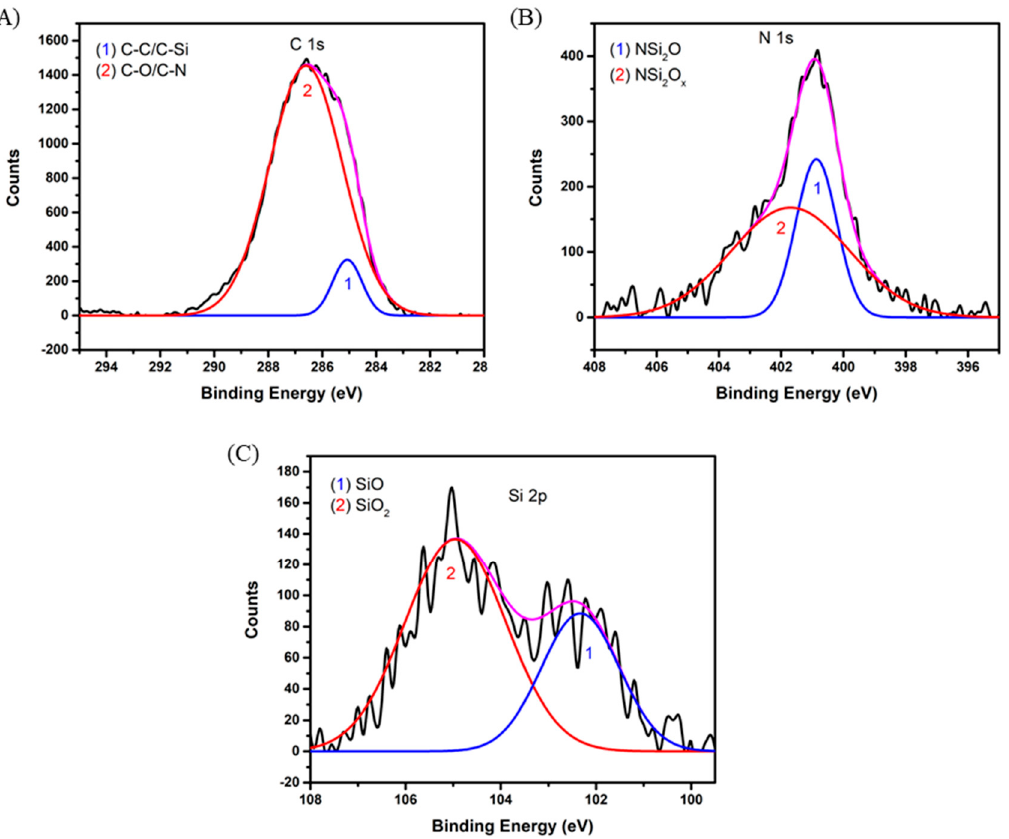
Figure 4. XPS high-resolution scans of ( A ) carbon, ( B ) nitrogen, and ( C ) silicon peaks in GQDs- hMSNs. The carbon peak shows C-O, C-Si, C-C and C-N bonds. The nitrogen peak is primarily NSi 2 O x . Lastly, the silicon peak shows SiO x